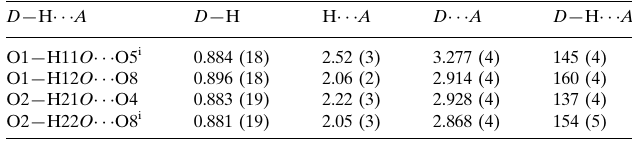
Hydrogen-bond geometry (A˚ , (cid:2)